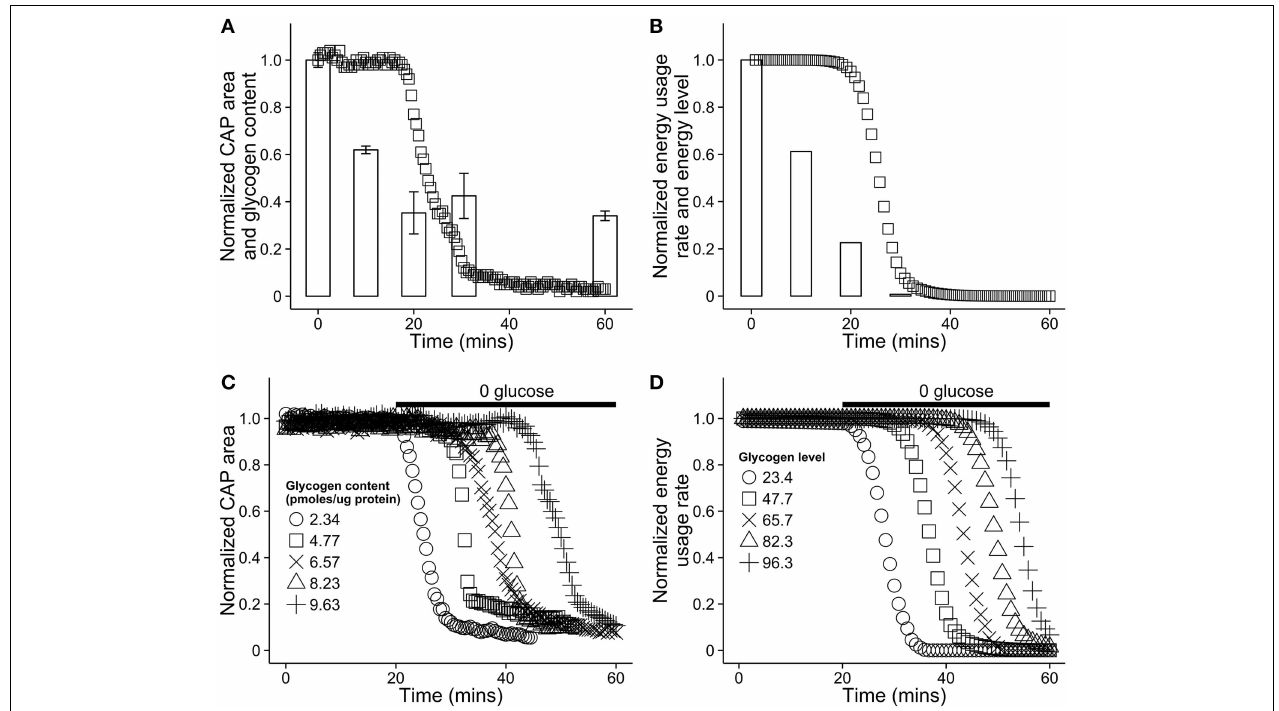
aglycemic conditions, the energy flow from the capillary, E B was set to 0 for the duration of the simulation. (C) Recorded CAP area in the mouse optic nerve in vitro as a function of time and the initial glycogen content in nearby astrocytes. At 20 min, the solution was replaced with a solution containing no glucose. Figure recreated using data from Brown et al. (2003). (D) A simulation of the same situation as (C) using our model. The absence of 25 % of ≈ glucose in solution was modeled by again setting E B 0 at 20 min. In our = model, astrocytic energy level ranges from 0 to 100, arbitrary